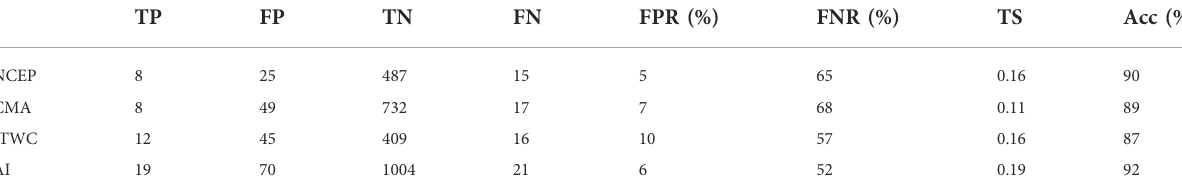
TABLE 2 Comparison table between AI algorithm and different subjective and objective forecasts.